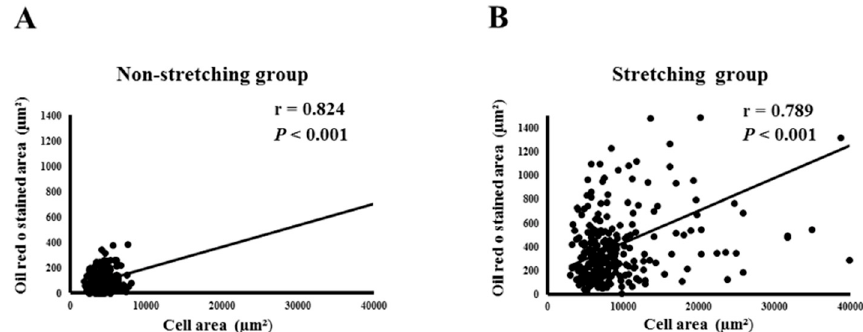
Figure 2. Correlation between cell size and Oil Red O-stained area of HL-1 atrial myocytes in the non-stretched control group ( A ) and stretched group ( B ).